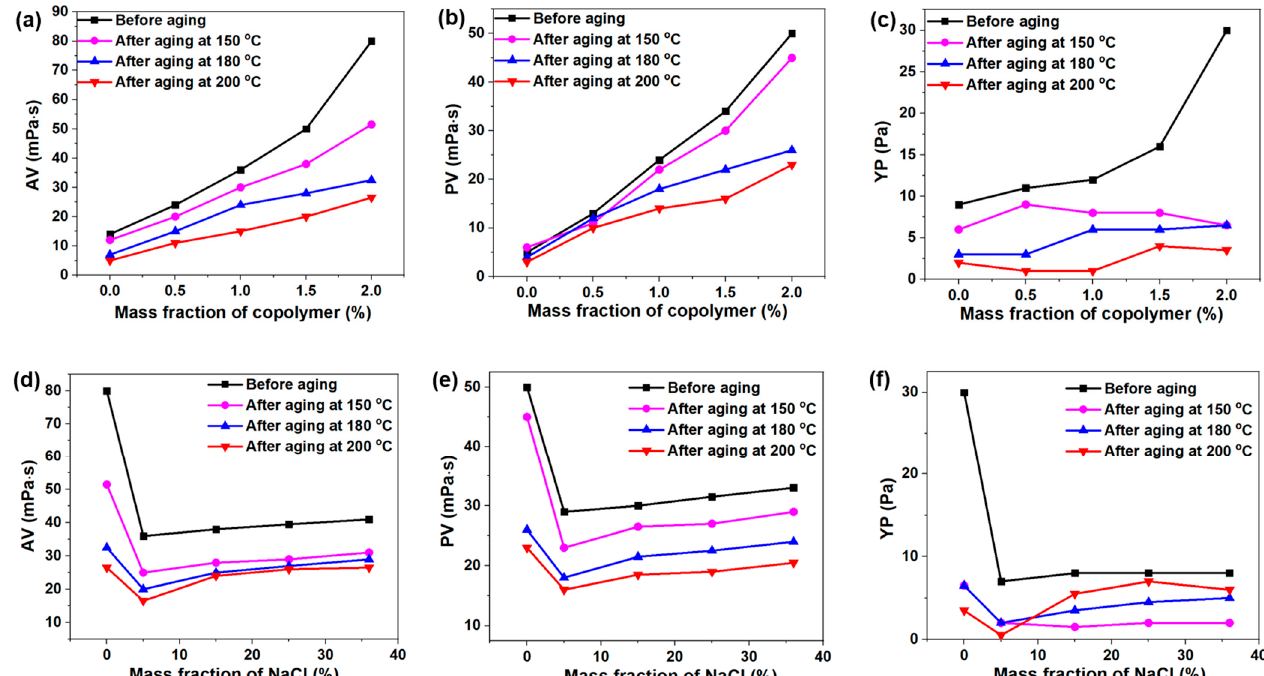
Figure 4. Rheological properties of DDAM-based drilling fluid with different contents before aging and after aging at 150 °C, 180 °C and 200 °C for 16 h: ( a ) AV; ( b ) PV; ( c ) YP. Rheological properties of 2 wt% DDAM-based drilling fluids with different fraction of NaCl before aging and after aging at 150 °C, 180 °C and 200 °C for 16 h: ( d ) AV; ( e ) PV; ( f ) YP.